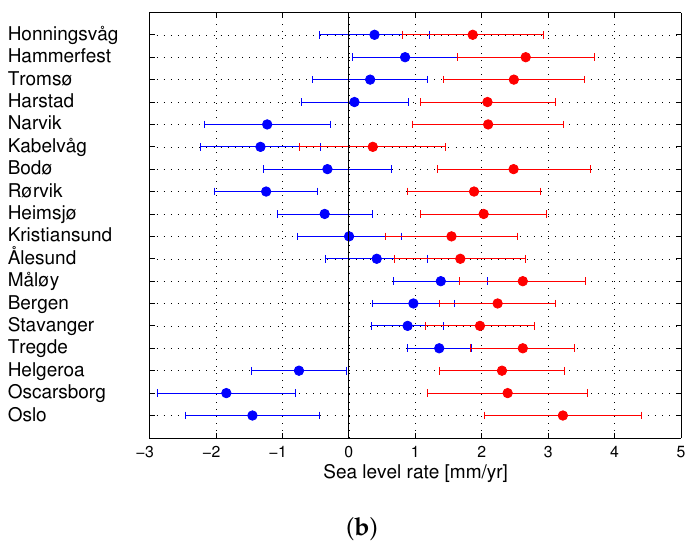
Figure 2. Relative (blue) and corrected (i.e., adjusted for vertical land motion as well as the gravity effect of glacial isostatic adjustment; red) sea-level rates with standard errors estimated from tide-gauge observations along the Norwegian coast. Rates are shown for ( a ) the period 1960 to 2010 and ( b ) the period 1984 to 2014. The stations are ordered along the coast from north to south.